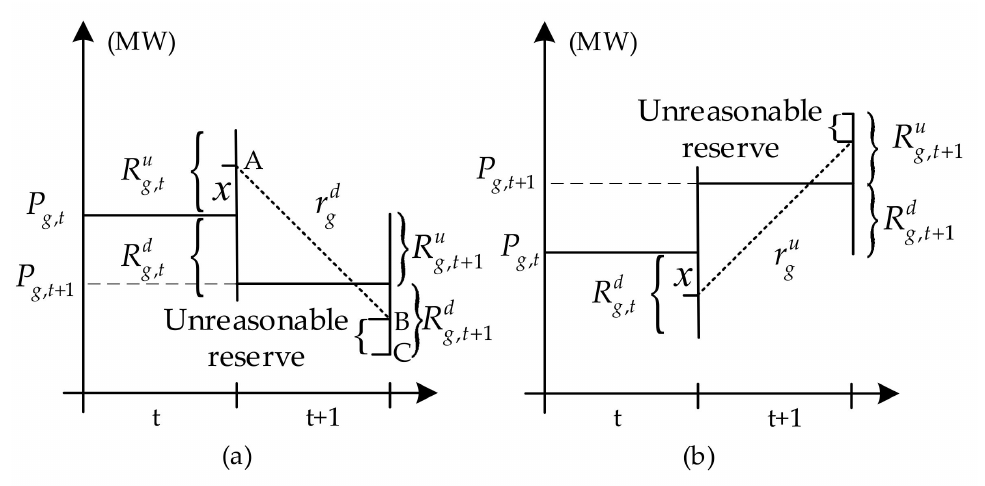
Figure 1. Unresponsive reserve from a generator due to time coupling. ( a ) The unresponsive downward reserve capacity. ( b ) The unresponsive upward reserve